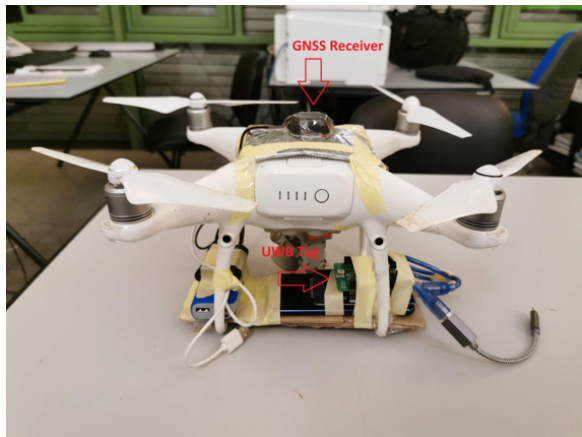
Figure 3. Drone flying close to the building